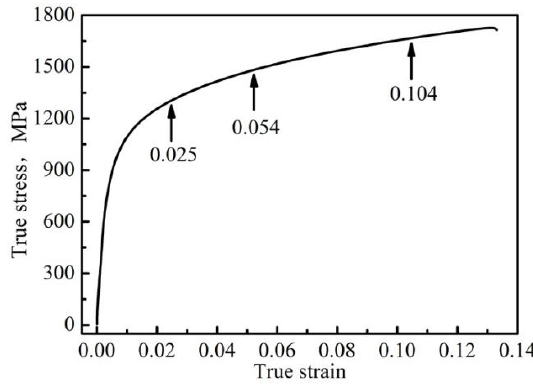
Figure 1. Schematic of the tensile specimen.